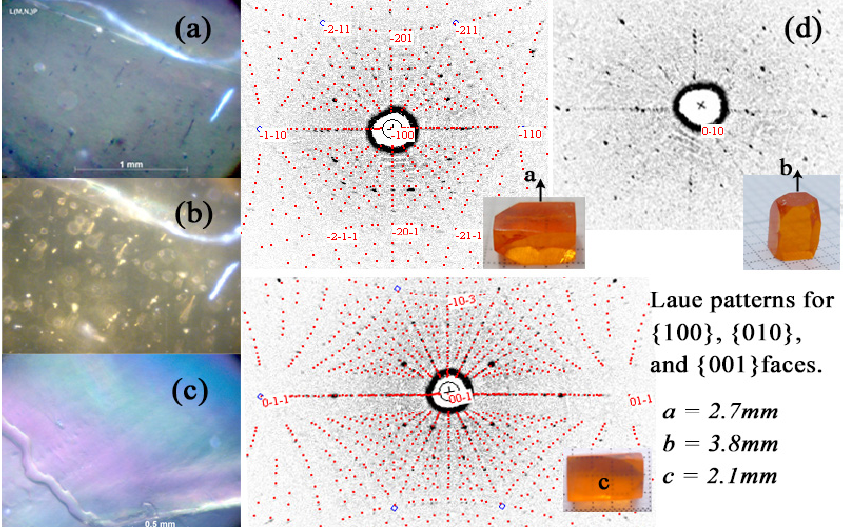
Figure 2. Polarization images in polarized light of both the ( a ) Q5, and ( b ) Q6 cross-sections cut from Table 0. The Ni 0.03 )PO 4 crystal, as well as the polarization images of ( c ) a 2 mm plate cut from Li(Mn 0.97 ,Ni 0.03 )PO 4 crystal boule; ( d ) The X-ray Laue backscattering images along the a , b , and c axes.